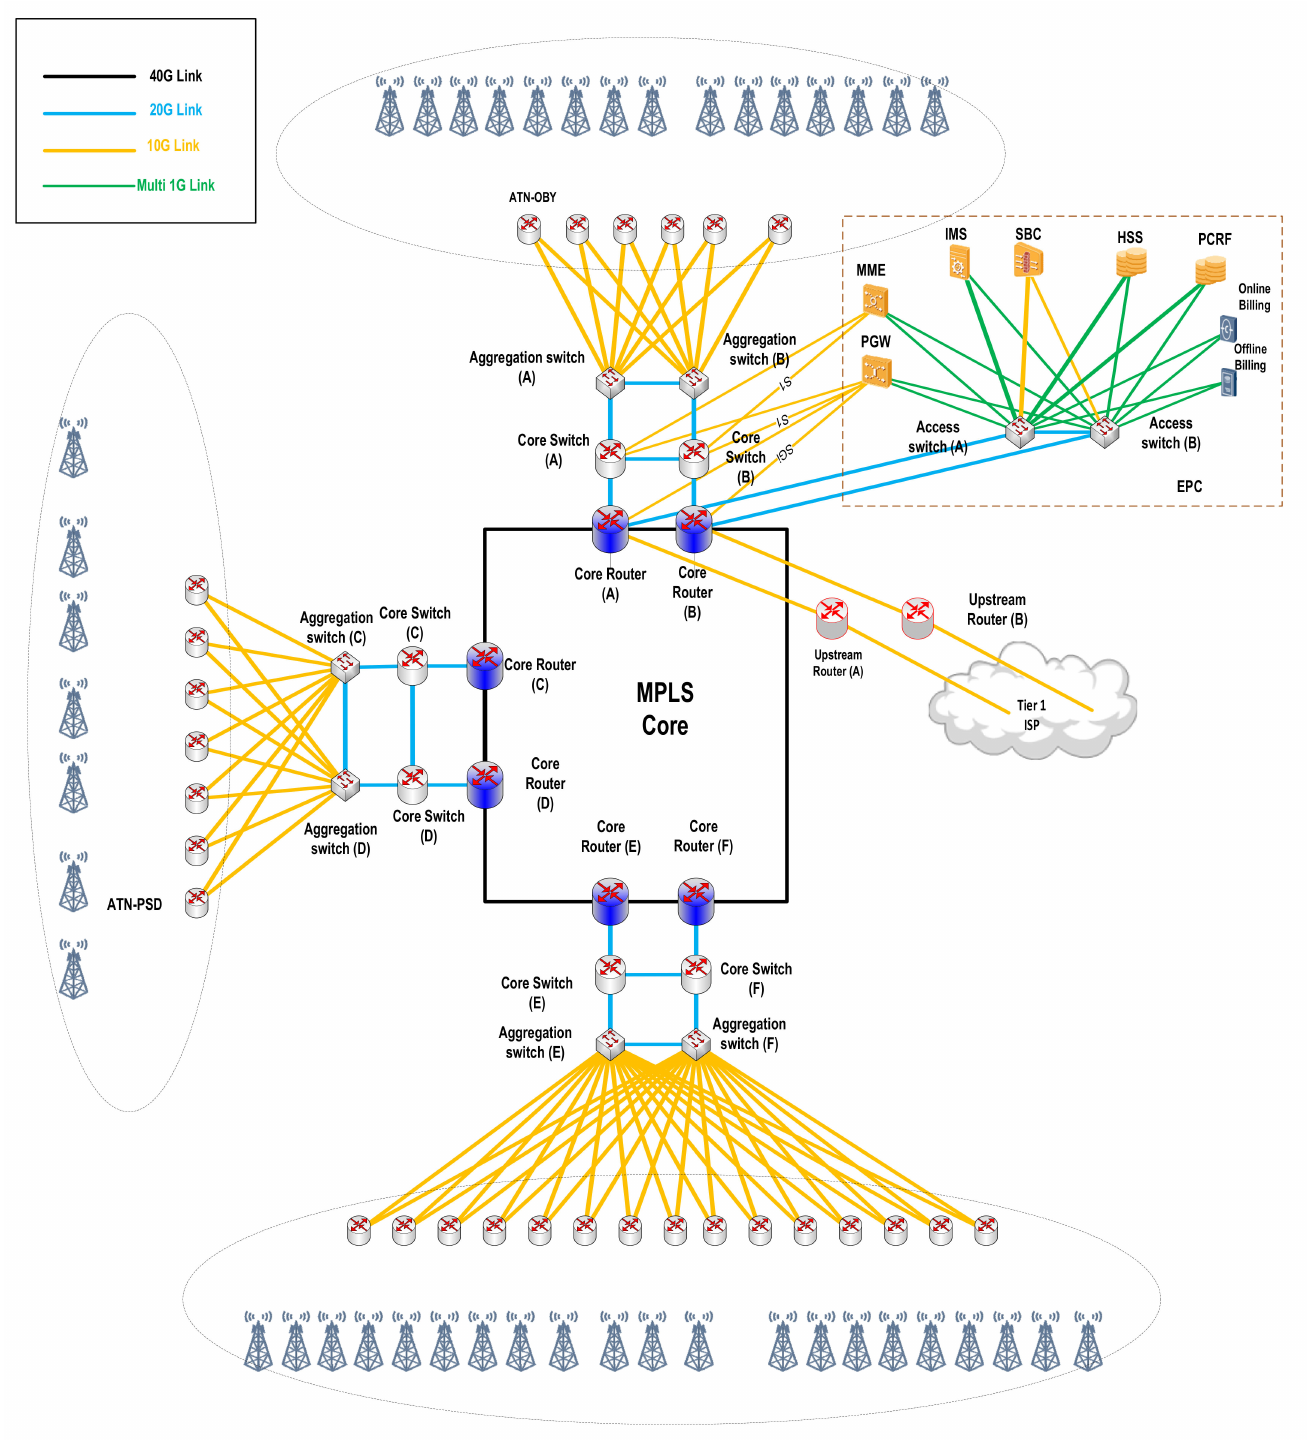
Figure 2. Backbone